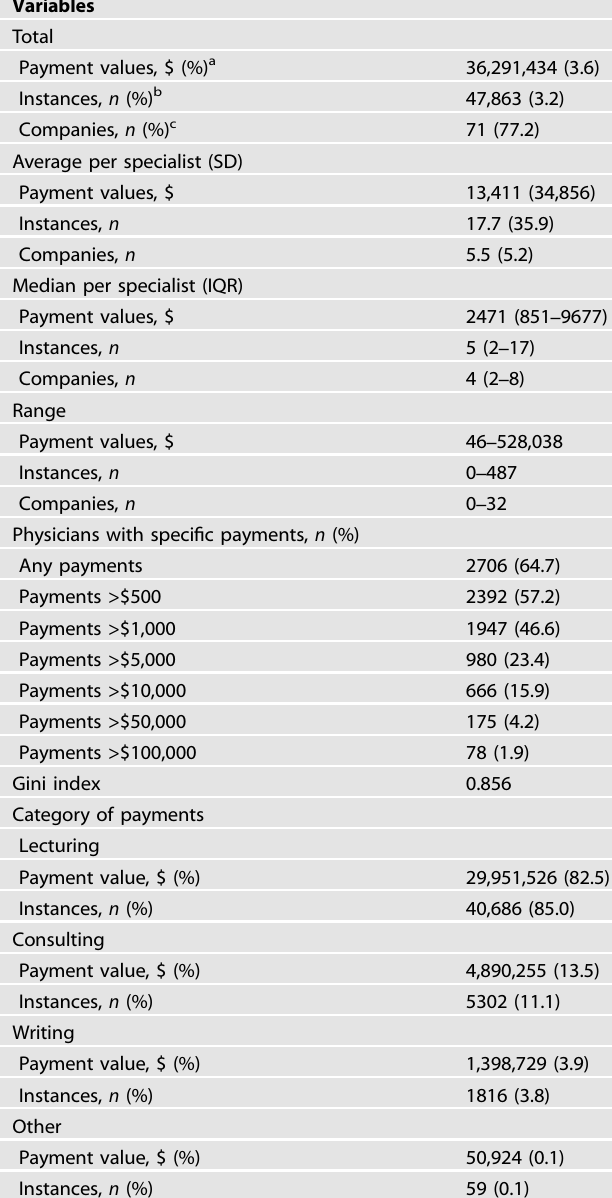
Table 1. Summary of personal payments from